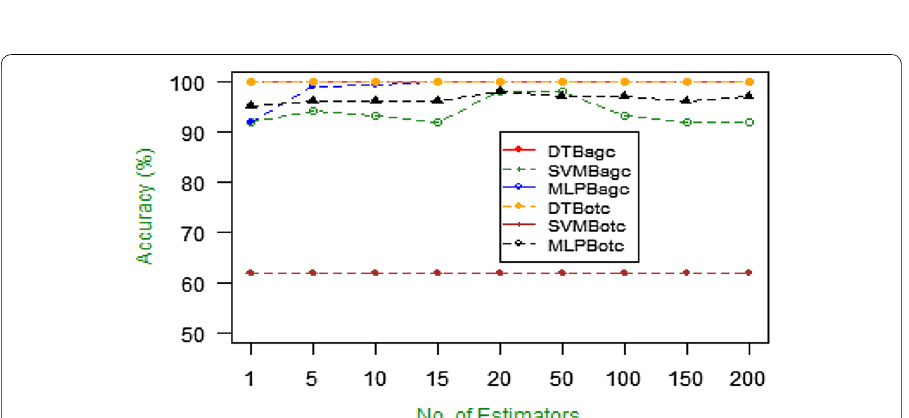
Fig. 7 Bagging and boosting classifiers accuracy over the BSE